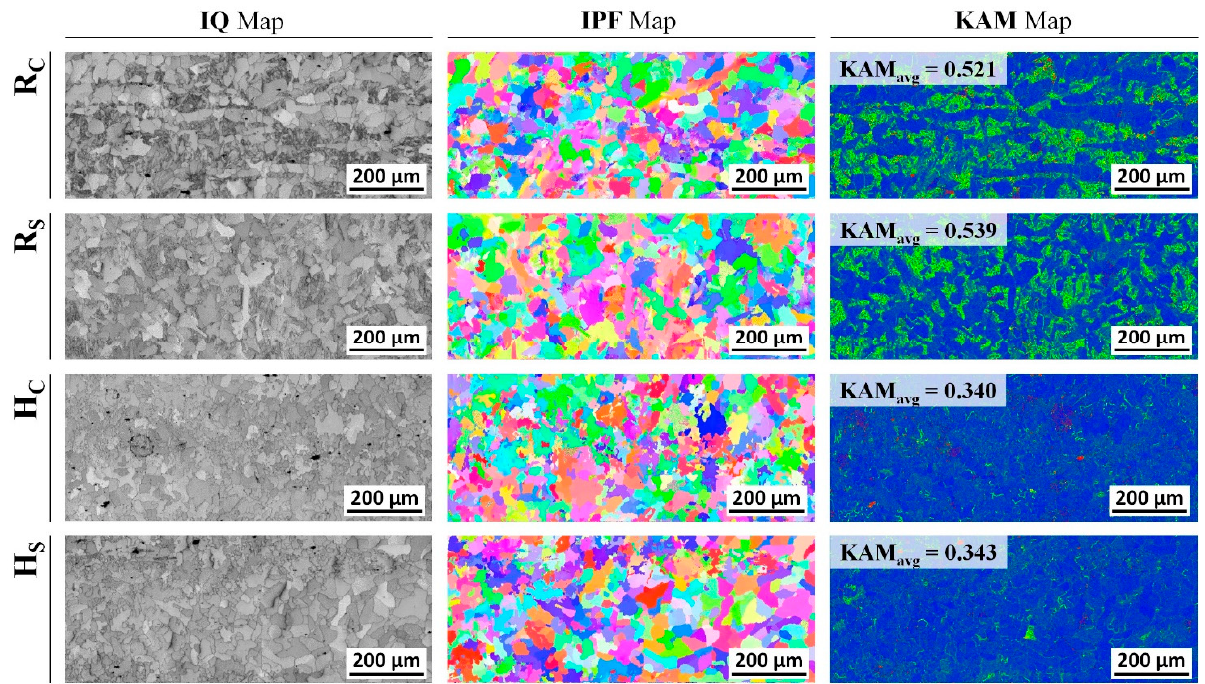
Figure 18. EBSD IQ map and IPF map, and KAM map, of raw and spheroidized-annealed specimen. For the cold forward-extruded preform, with consideration of the residual stress level and the plastic deformation damage degree predicted through the numerical simulations in which the elasto-plastic material model was adopted, the IQ map and the IPF map, along with the KAM map, were observed at each region denoted in Figure 19. Regarding the EBSD IQ maps and IPF maps on the central core region as illustrated in Figure 20a, it can be seen that the dislocation density at each section (P 1C , P 2C , P 3C , P 4C ) was distinctly increased through a comparison with that at H C of the heat-treated initial workpiece, and that the grain boundary was not clearly distinguished. With regard to the KAM map, the values of KAM avg were calculated to be 2.09 at P 1C , 2.18 at P 2C , 2.42 at P 3C , and 2.51 at P 4C , while those from P 1C to P 4C were highly increased in comparison to the value of about 0.34 at H C of the heat-treated initial workpiece. Furthermore, the EBSD analysis was also conducted around the outer surface regions as depicted in Figure 20b. Around the outer surface part within the cold forward-extruded preform, the IQ maps from P 1S to P 4S explained that the dislocation density was evidently increased as the cold forward extrusion progressed, and the IPF maps indicated that the grain boundaries were clearly distinguished at P 1S to P 2S , but these boundaries at P 3S to P 4S were difficult to clarify after passing the extrusion outlet (that is, the neck section). In view of the KAM map, the value of KAM avg at P 1S was observed to be 1.221, and therefore larger than that of 0.343 at H C of the spheroidized and annealed specimen, and it was revealed that the value is highly distributed with 2.086 at P 2S , 2.265 at P 3S , and 2.321 at P 4S